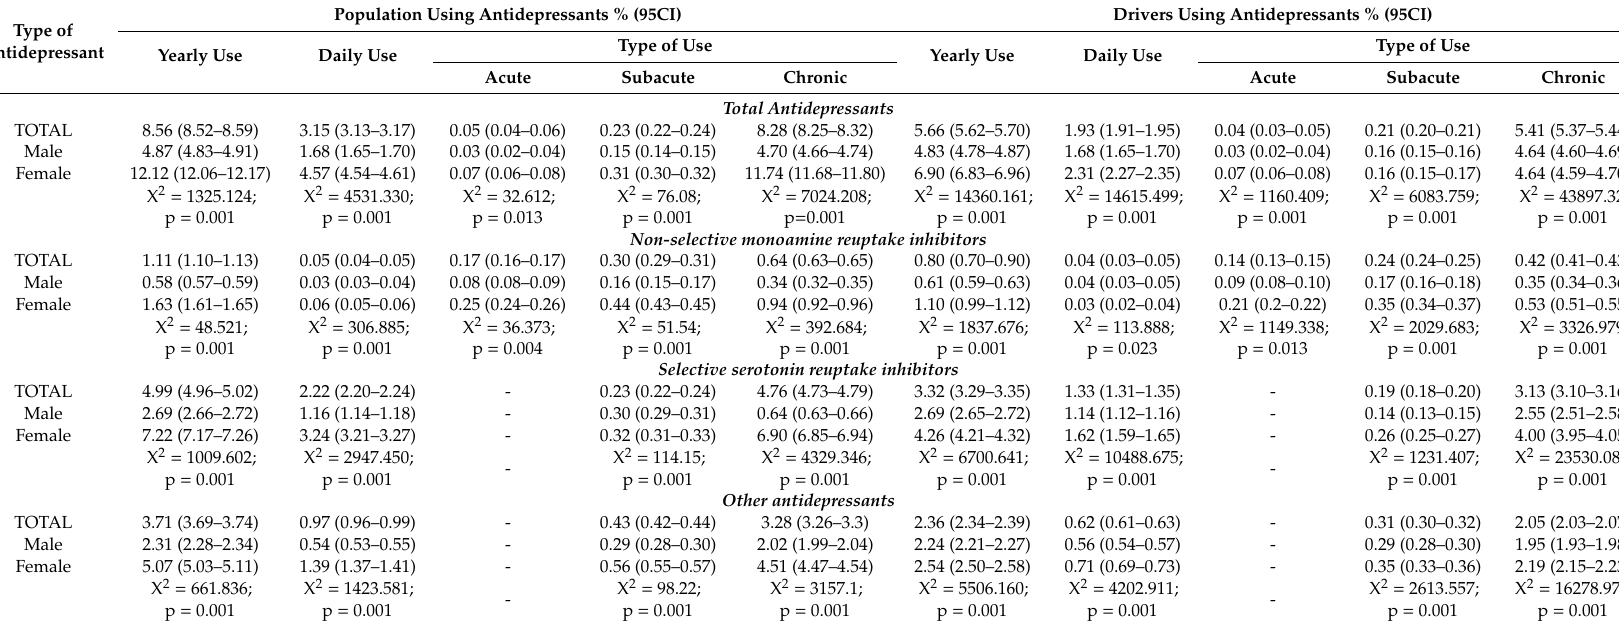
Table 1. Antidepressants consumption according to the CONCYLIA database and the Castile and Le ó n drivers’ license census